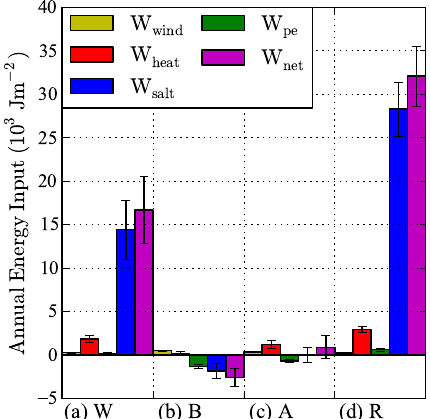
Fig. 12. Mean (1985–2011) annual (mechanical) energy input to the mixed layer from the time integral of each power input term as discussed in Sect. 2.1.2. The error bars shown correspond to one standard deviation from the mean. W: Weddell, B: Bellingshausen, A: Amundsen, R: Ross, which correspond to the shelf sea regions shown in Fig.